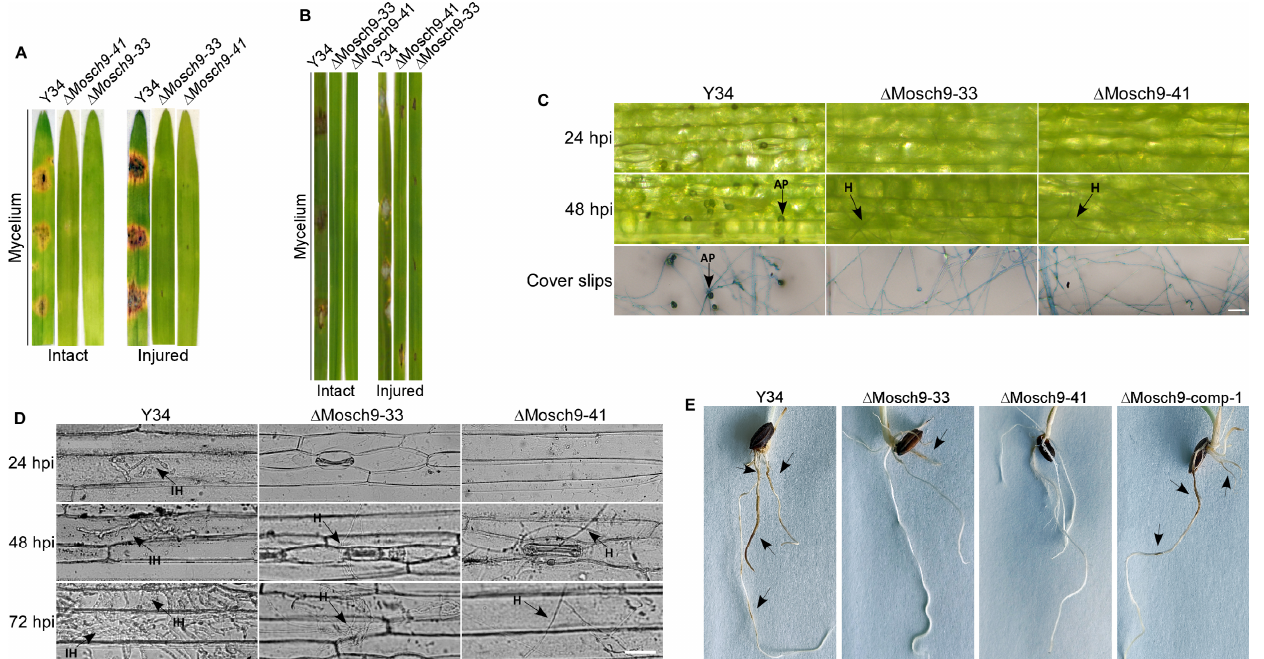
Figure 3. Impact of MoSch9 gene deletion on hyphal mediated pathogenicity, appressorium morpho- genesis, penetration, and root infection capability of M. oryzae . Hyphal-mediated infection capability of the ∆ Mosch9 strains on intact and injured detached ( A ) barley and ( B ) rice leaves compared to wild-type strains. ( C ) Development of appressorium-like structures and ( D ) Hyphal mediated pene- tration on barley leaves inoculated with MoSch9 mutant strains and wild type mycelia. Scale = 20 µ m. ( E ) Rice root infection evaluation at 5 dpi. Arrows show the infection sites. Nearly all results were obtained from three